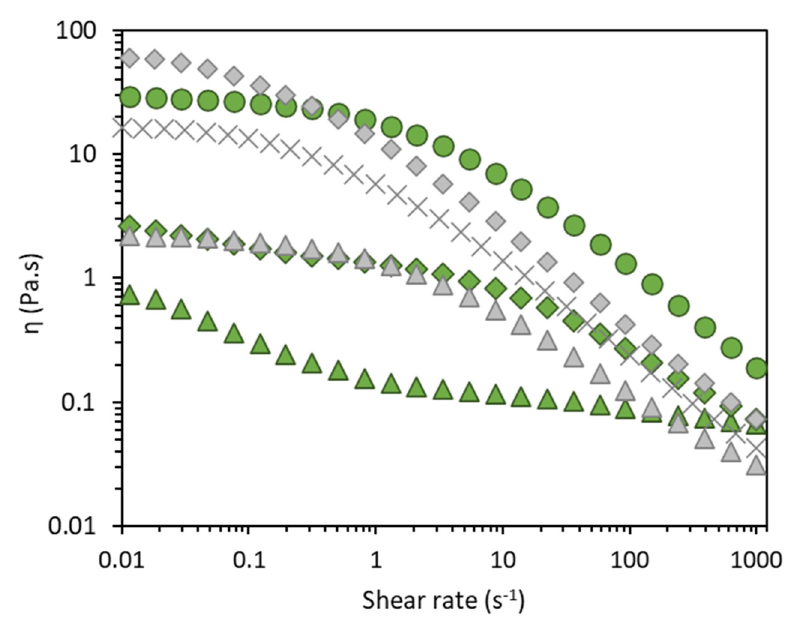
Figure 3. Flow curves of d − FucoPol (green) and FucoPol (grey) aqueous solutions: 0.75 wt% (triangles), 1.0 wt% (asterisk), 1.5 wt% (diamonds), and 3.0 wt% (circles). Table 2. Cross model parameters estimated for d-FucoPol and Fucopol solutions. η 0 —apparent vis- cosity of the first Newtonian plateau (Pa·s); τ — relaxation time (s); and m —dimensionless constant. Data are shown as the average ± standard deviation (SD) (n = 3). * Cross model is not appropriate to describe experimental data.